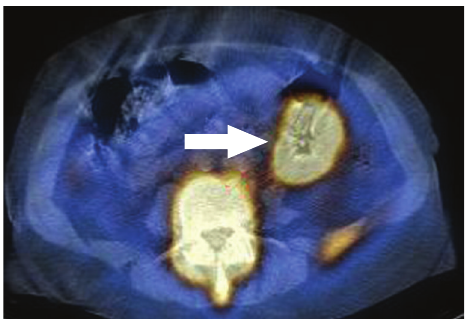
Figure 8: The same patient, abdomen SPECT/CT, transversal slice. Granulocyte uptake in the ileum—m. Crohn ( arrow head ). Normal uptake of the radiotracer in bone